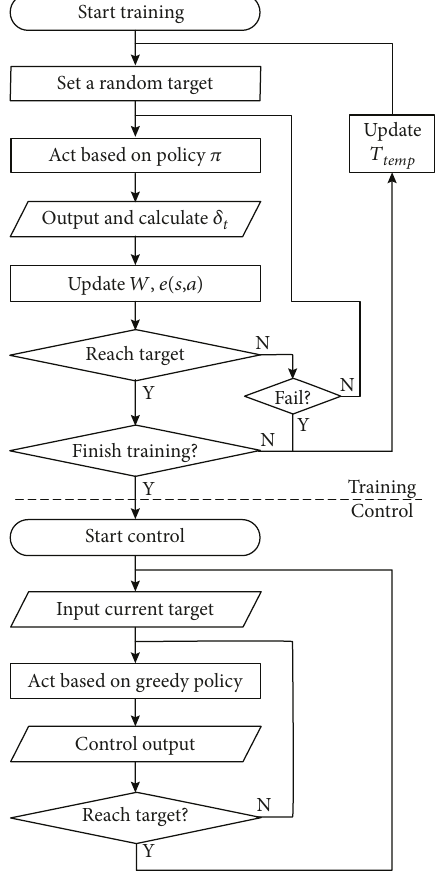
Figure 5: Training and control